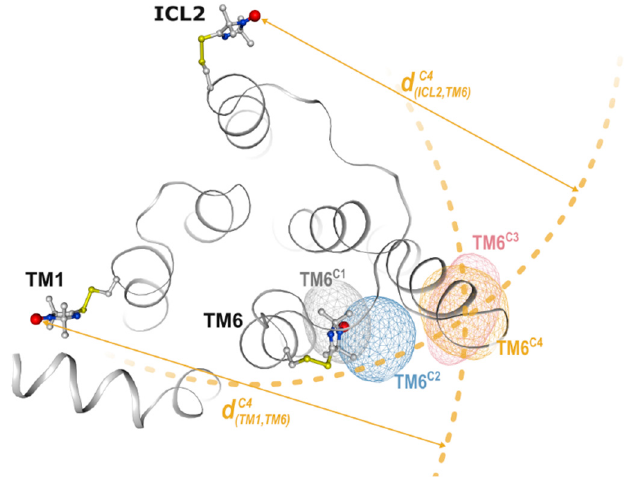
Figure 4. DEER mapping. Cytoplasmic surface of AT1R with spin label side chains modeled indicating the reference sites, TM1 and ICL2, and the monitor site TM6. Shown spin densities were calculated from main NNMF distances via 2D trilateration. For TM6 C4 , the used distances d C4 and intersecting spheres (dotted lines) are shown for visualization. The underlying structure was derived from MD simulations of antagonist bound AT1R [38].